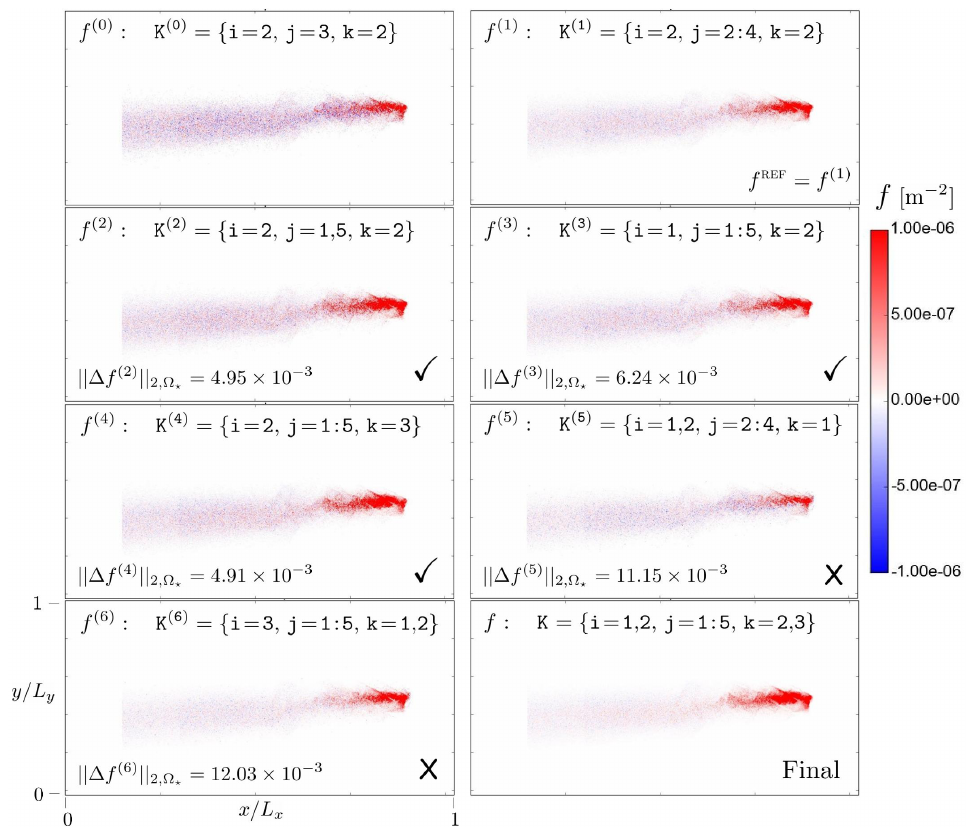
Figure 6. Illustration of the selective assembly of the final footprint for n x × n y × n z = 3 × 5 × 3 = 45. Values of || (cid:49)f (l) || 2 ,(cid:127) discrepancy between f REF and f (l) are shown where applicable. Acceptable candidates are marked by (cid:88) and the rejected by × . Note the use of short-hand notation, e.g., 1 : 3 = 1 , 2 ,